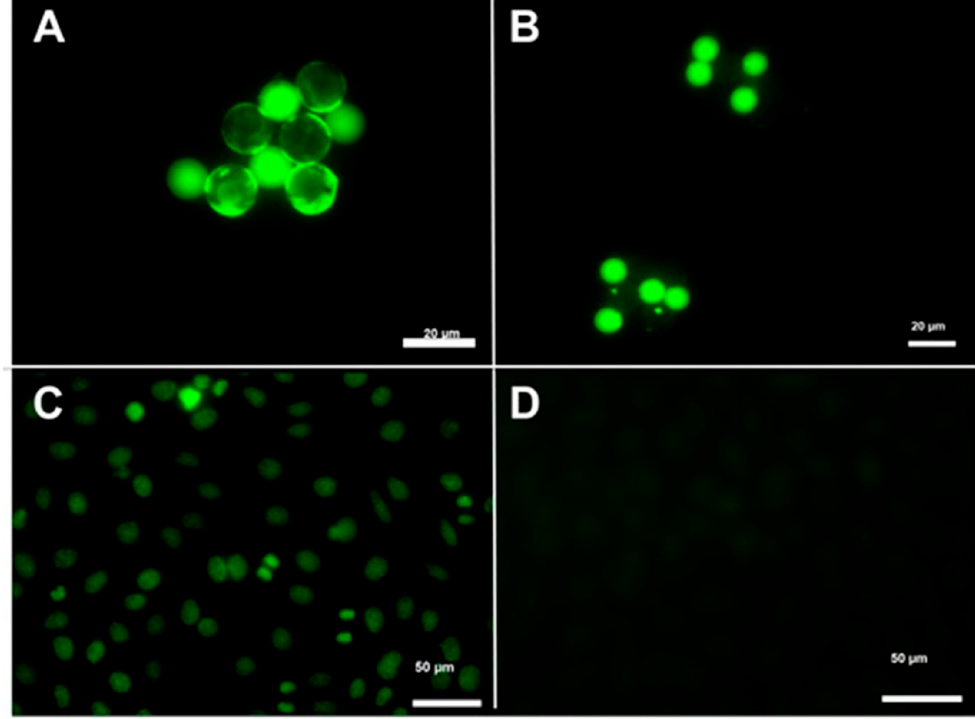
Figure 2. Indirect immunofluorescence for ANA. ( A ) Positive Cytobeads ANA for DFS70, positive antibodies in diluted patient serum react specifically with antigens on beads fixed onto slides/Cytobeads ANA for DFS70. Ring fluorescence of the antigen large, coated beads shows the presence of DFS70 and small bead small coated beads correspond to the internal control of the technique. 40X. ( B ) Positive internal control on coated small beads in an ANA/DFS70 negative patient sample. 40X. ( C ) ANA: Nuclear dense fine speckled AC-2 (Speckled pattern distributed throughout the interphase nucleus with characteristic heterogeneity in the size of Hep-2 cells. ( D ) ANA: Negative (AC-0). Absence of clear-cut staining in any given subcellular structure on Hep-2 cells. 40×. Nomenclature: International Consensus on Antinuclear Antibody (ANA) Patterns (ICAP). https://www.anapatterns.org/index.php (last accessed 23 June 2022).